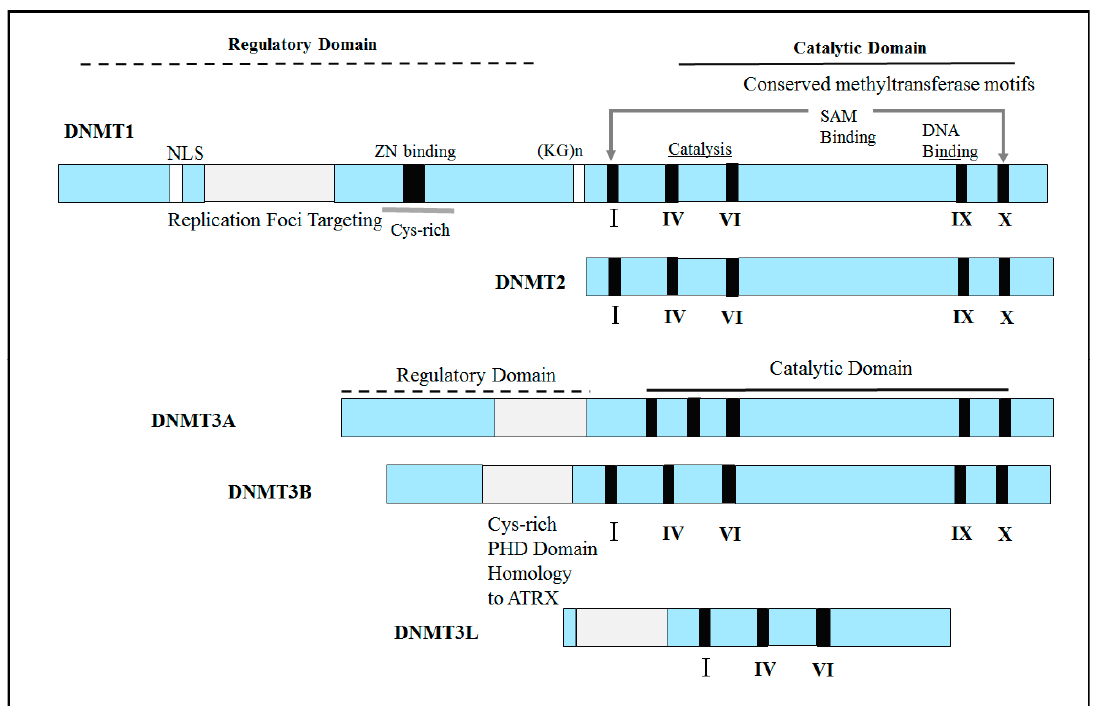
Figure 3. The structures of the known DNMTs contain two domains, regulatory and catalytic. Roman numerals refer to conserved motifs of DNA methyl transferase [45].